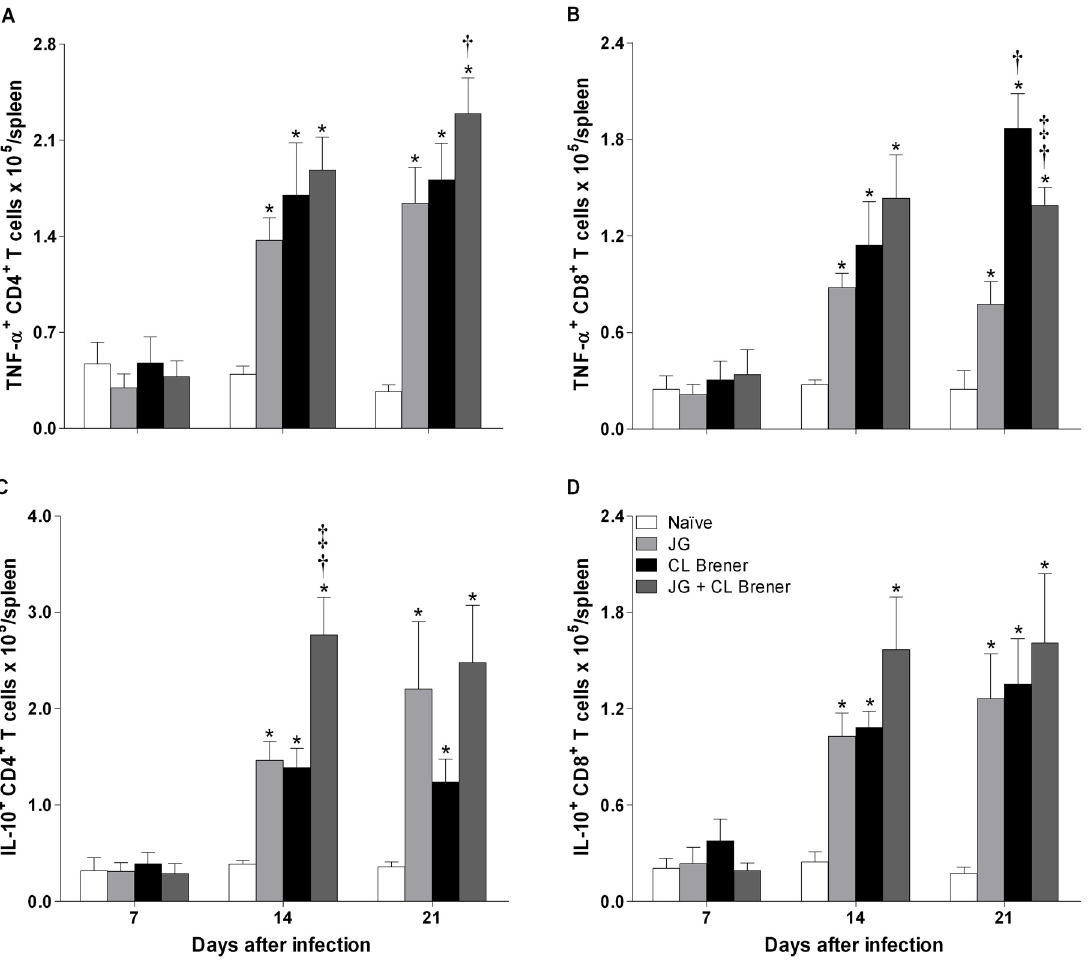
Figure 8. Flow cytometry analysis of splenic CD4 + T and CD8 + T cells from BALB/c mice infected with JG and/or CL Brener. Groups of mice were infected with 100 trypomastigotes of JG or CL Brener (single infection) or coinfected with 100 trypomastigotes of both T. cruzi populations in a 1:1 ratio via the intraperitoneal route, and flow cytometry analysis of splenic CD4 + T and CD8 + T cells were performed at 7, 14 and 21 days p.i. Symbols as follow: (A) TNF- a + /CD4 + ; (B) TNF- a + /CD8 + ; (C) IL-10 + /CD4 + ; (D) IL-10 + /CD8 + ; white bar: Naı¨ve mice; light gray bar: JG infected mice; black bar: CL Brener infected mice; and dark gray bar: JG and CL Brener infected mice. Values are expressed as the mean 6 SEM of three mice per group (representative of two independent experiments). *, { and { represent P , 0.05 when compared with naı¨ve, JG and CL Brener mice groups, respectively.